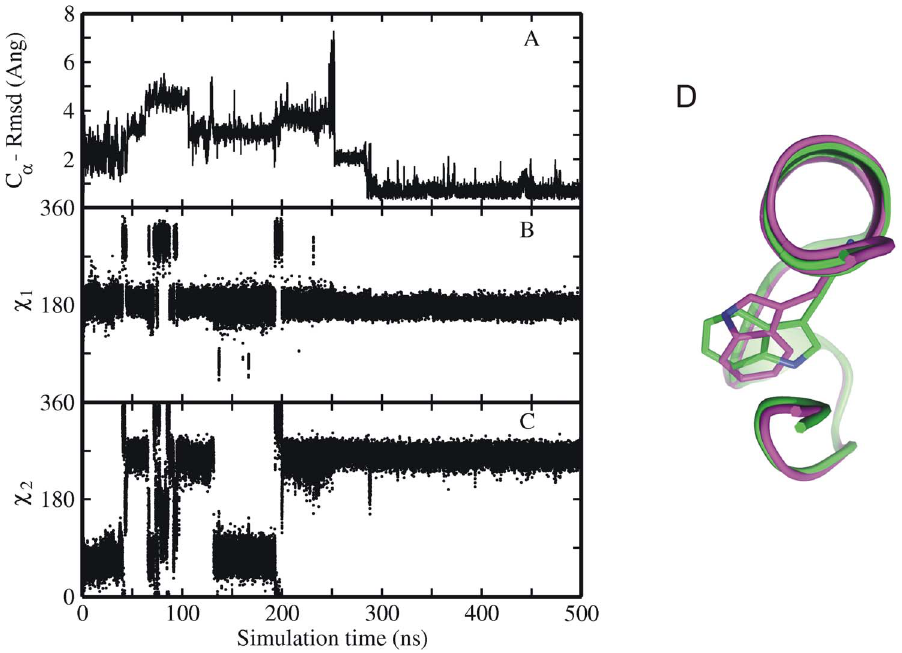
Figure 9. MD simulation of native Trp-cage structure with non-native Trp6 orientation. (A) Root-mean –square deviation (RMSD C a ) and (B, C) side chain dihedral angels of Trp6 residue of sampled Trp-cage conformations in explicit solvent starting from native structure with Trp6 residue in incorrect orientation versus simulation time with force field ff03. (D)The right panel shows the superposition of two examples of Trp-cage structures with the Trp6 side chain in the native conformation (green, x 2:270 u ) and the in a flipped (incorrect, x 2:60 u ) conformation (magenta). Average values of side chain dihedrals angels ( x 1 and x 2) of Trp-6 residue of sampled Trp-cage conformations correspond to 180 u and 270 u .